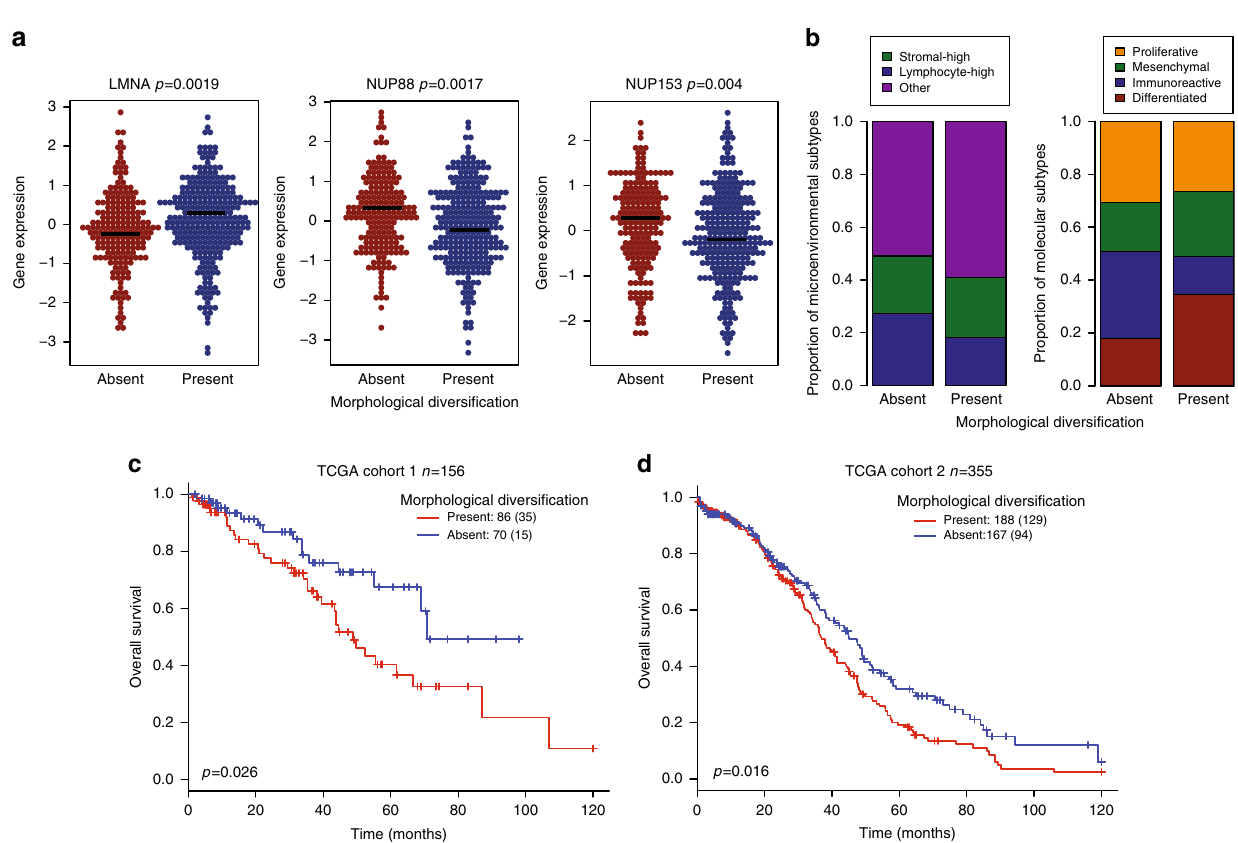
Fig. 2 The biological and clinical relevance of morphological diversi fi cation. a Swarm plots for LMNA , NUP88 , NUP153 expression in samples with and without diversi fi cation. b Barplots illustrating the fraction of microenvironmental subtypes (left) and molecular subtypes (right) strati fi ed by diversi fi cation. c Kaplan-Meier curves to show the prognostic value of diversi fi cation in OS for TCGA cohort 1 and d cohort